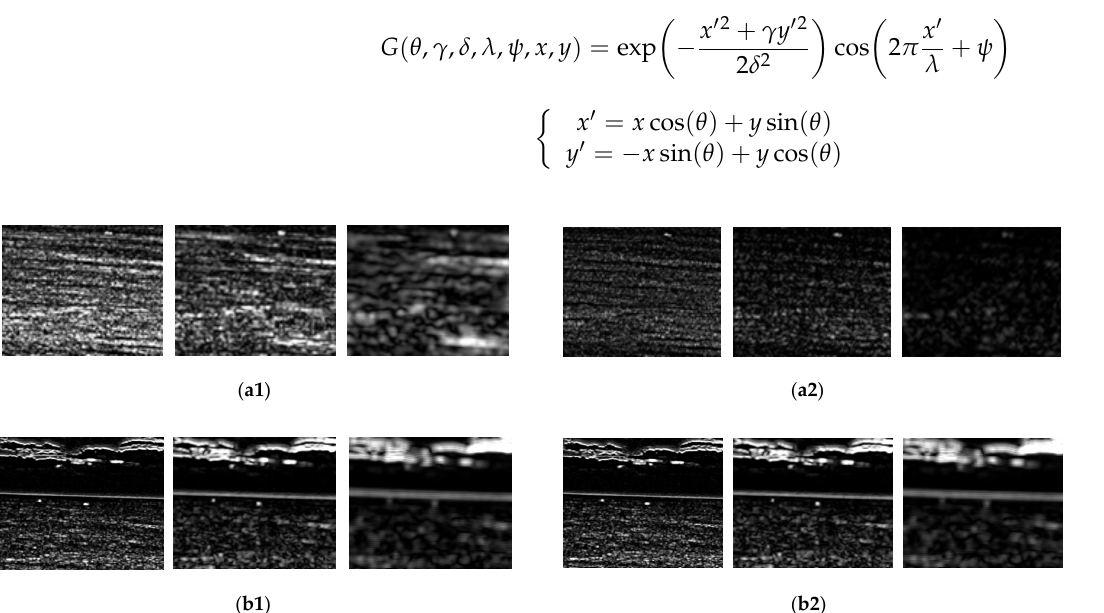
Figure 5. Multi-scale horizontal and vertical texture feature extraction results. ( a1 ) Horizontal texture features in multi-scale image A. ( a2 ) Vertical texture features in multi-scale image A. ( b1 ) Horizontal texture features in multi-scale image B. ( b2 ) Vertical texture features in multi-scale image B.